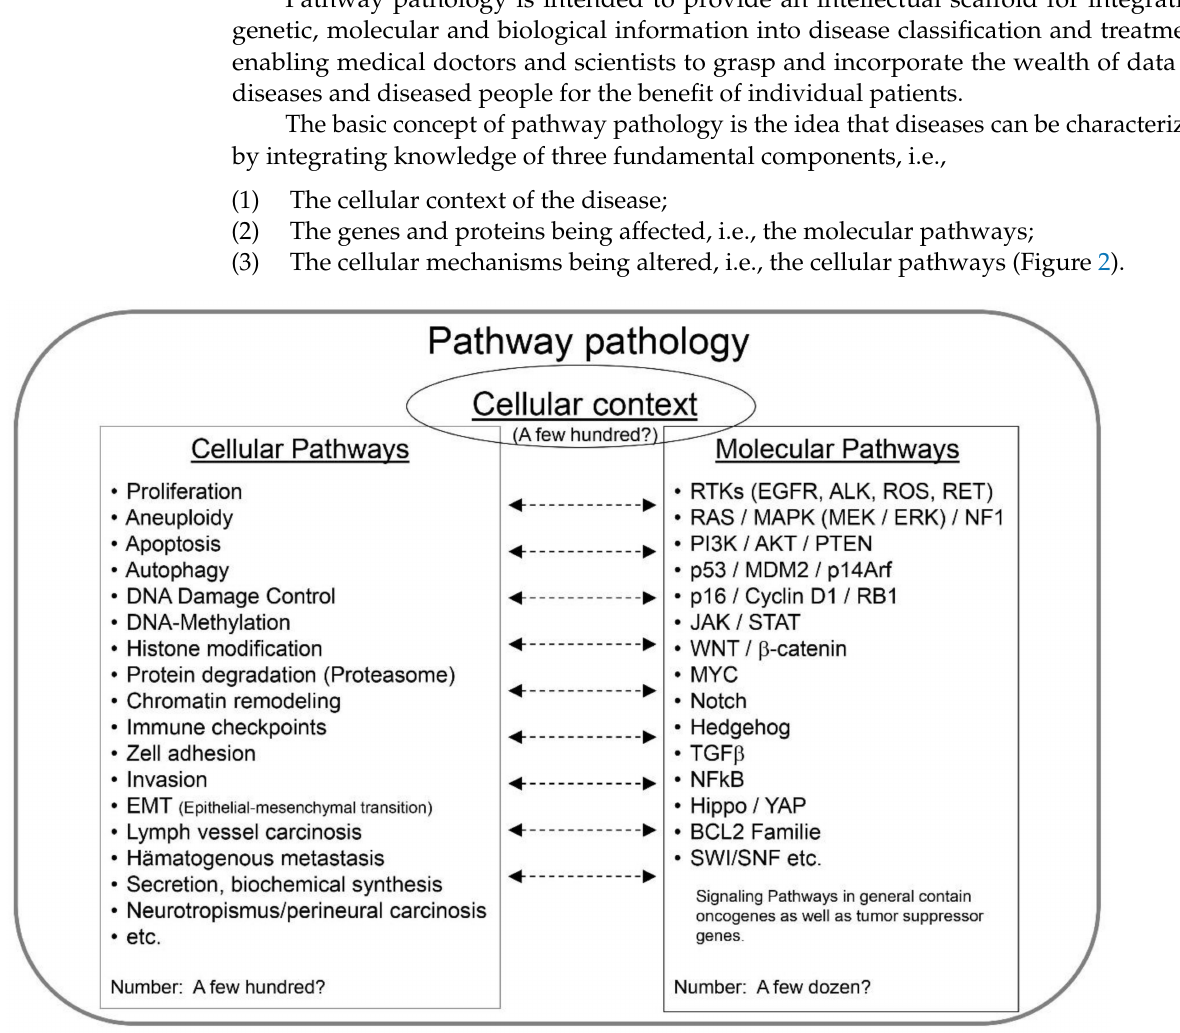
Figure 2. The pathway pathology of any disease can be rationalized by the primary cells and their cellular context that initiates the disease as well as the molecular pathways (genes and signaling pathways) and cellular mechanisms/pathways driving it. Knowing these components and their relevance is essential not only for a correct classification but also for an effective therapy. This is particularly true for complex diseases, such as cancer, that often carry multiple mutations and many active cellular